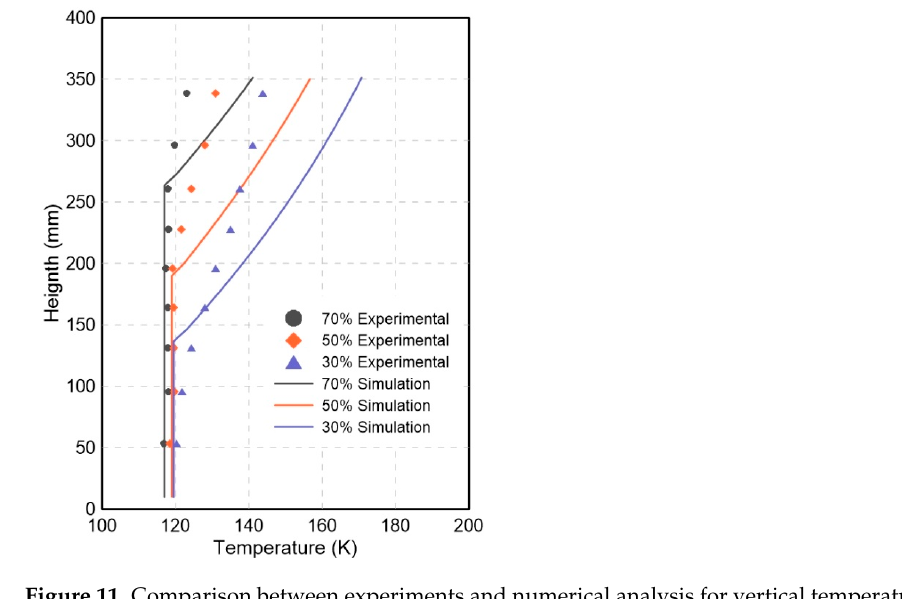
Figure 11. Comparison between experiments and numerical analysis for vertical temperature pro- file.